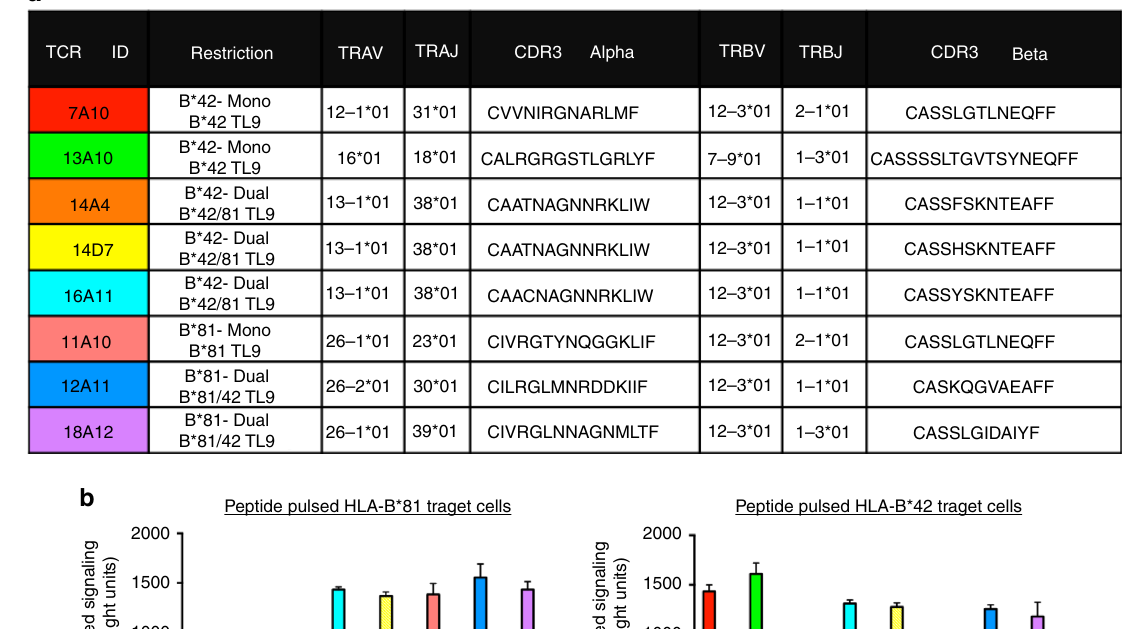
function contributed to this phenotype. The three TCR clones isolated from B*81:01 expressing individuals (one mono- and two dual-reactive) displayed similar overall TL9 variant cross- recognition pro fi les, as demonstrated by Spearman R-values >0.80 for all pair-wise associations; however, greater breadth against variants at position 4 (aspartic acid) was seen for clone